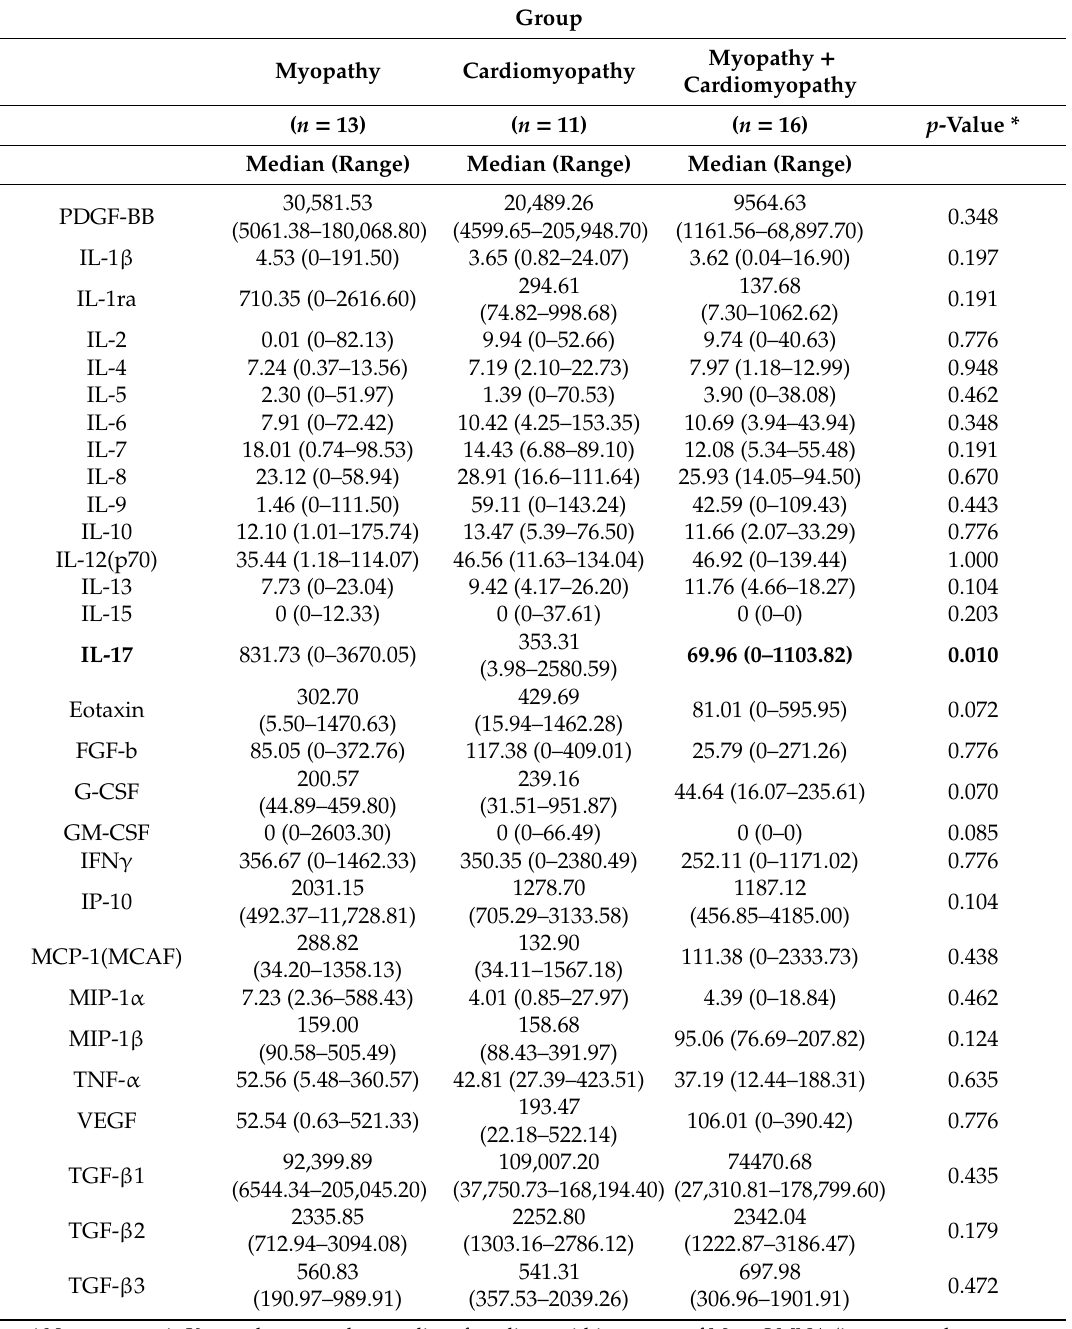
Table 3. Cytokine profile in Musc-LMNA